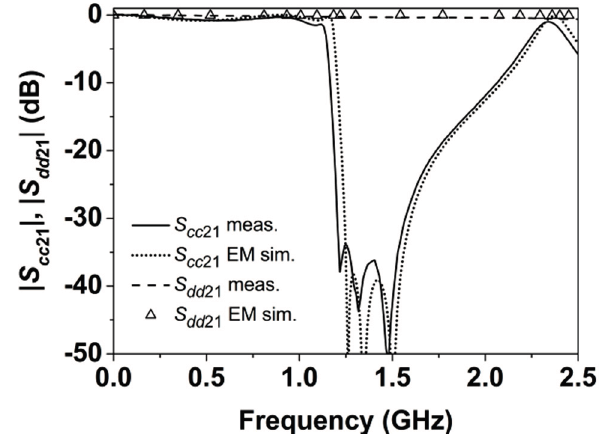
Figure 17. Photograph of the ( a ) top view and ( b ) bottom view of the differential line with wideband common-mode rejection. Dimensions are: c = 1.2 mm, d = 0.8 mm, W = 1 mm, S = 2.5 mm, and CSRR side length of 10.8 mm. The substrate is Rogers RO3010 with h = 1.27 mm, ε r = 10.2, and loss tangent tan δ = 0.0023.